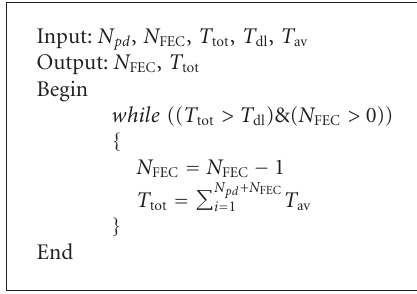
Algorithm 2: Enforcing the time constraint at the data-link